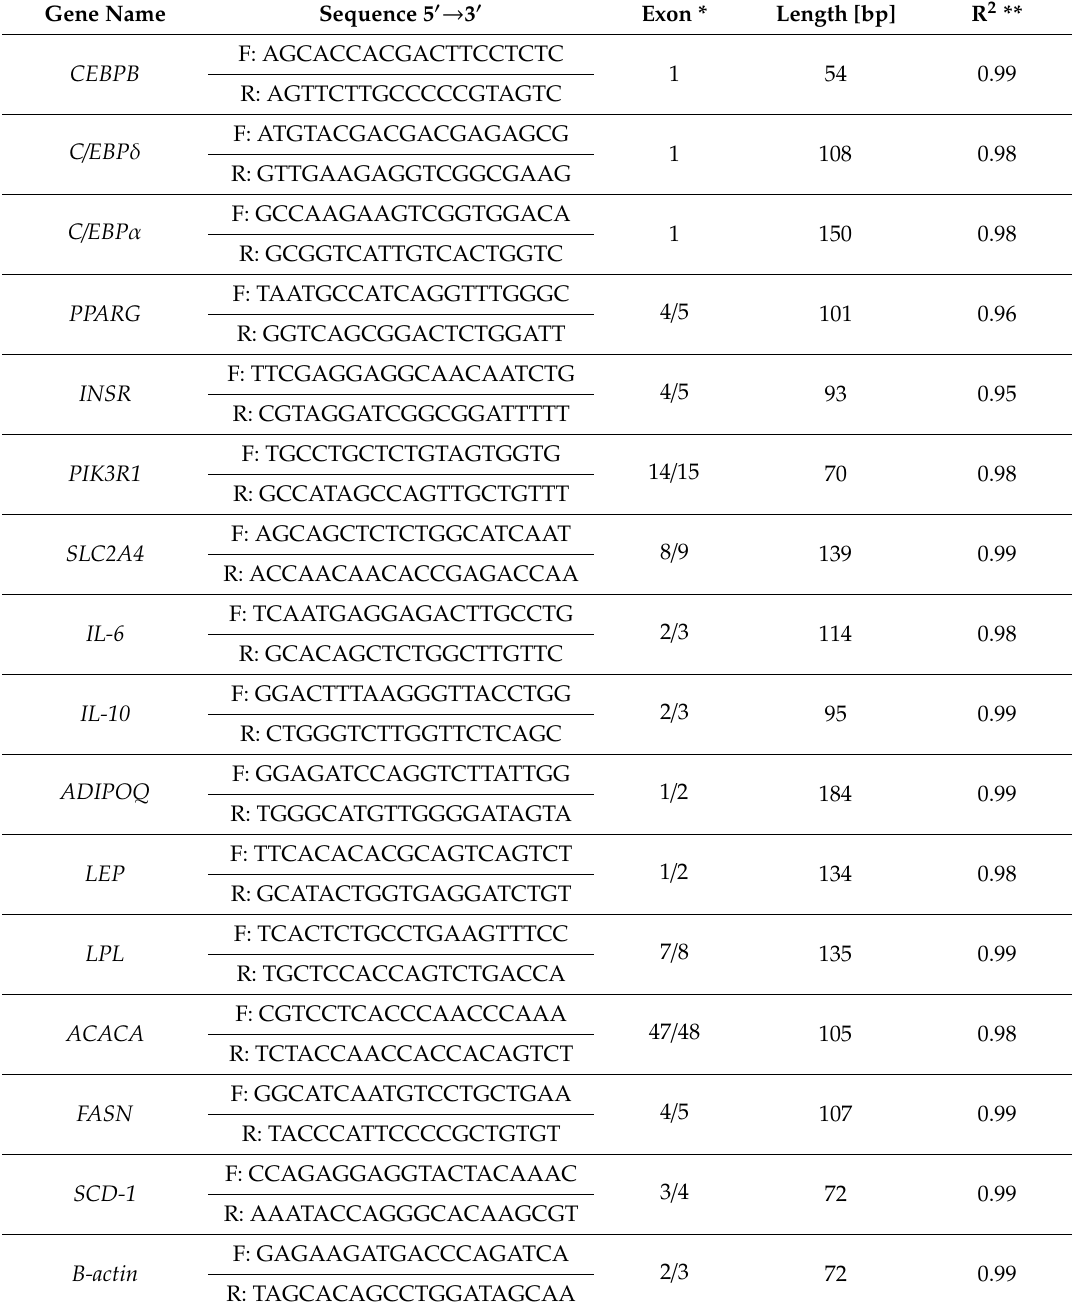
Table 1. Sequences of primers used in the study for gene expression